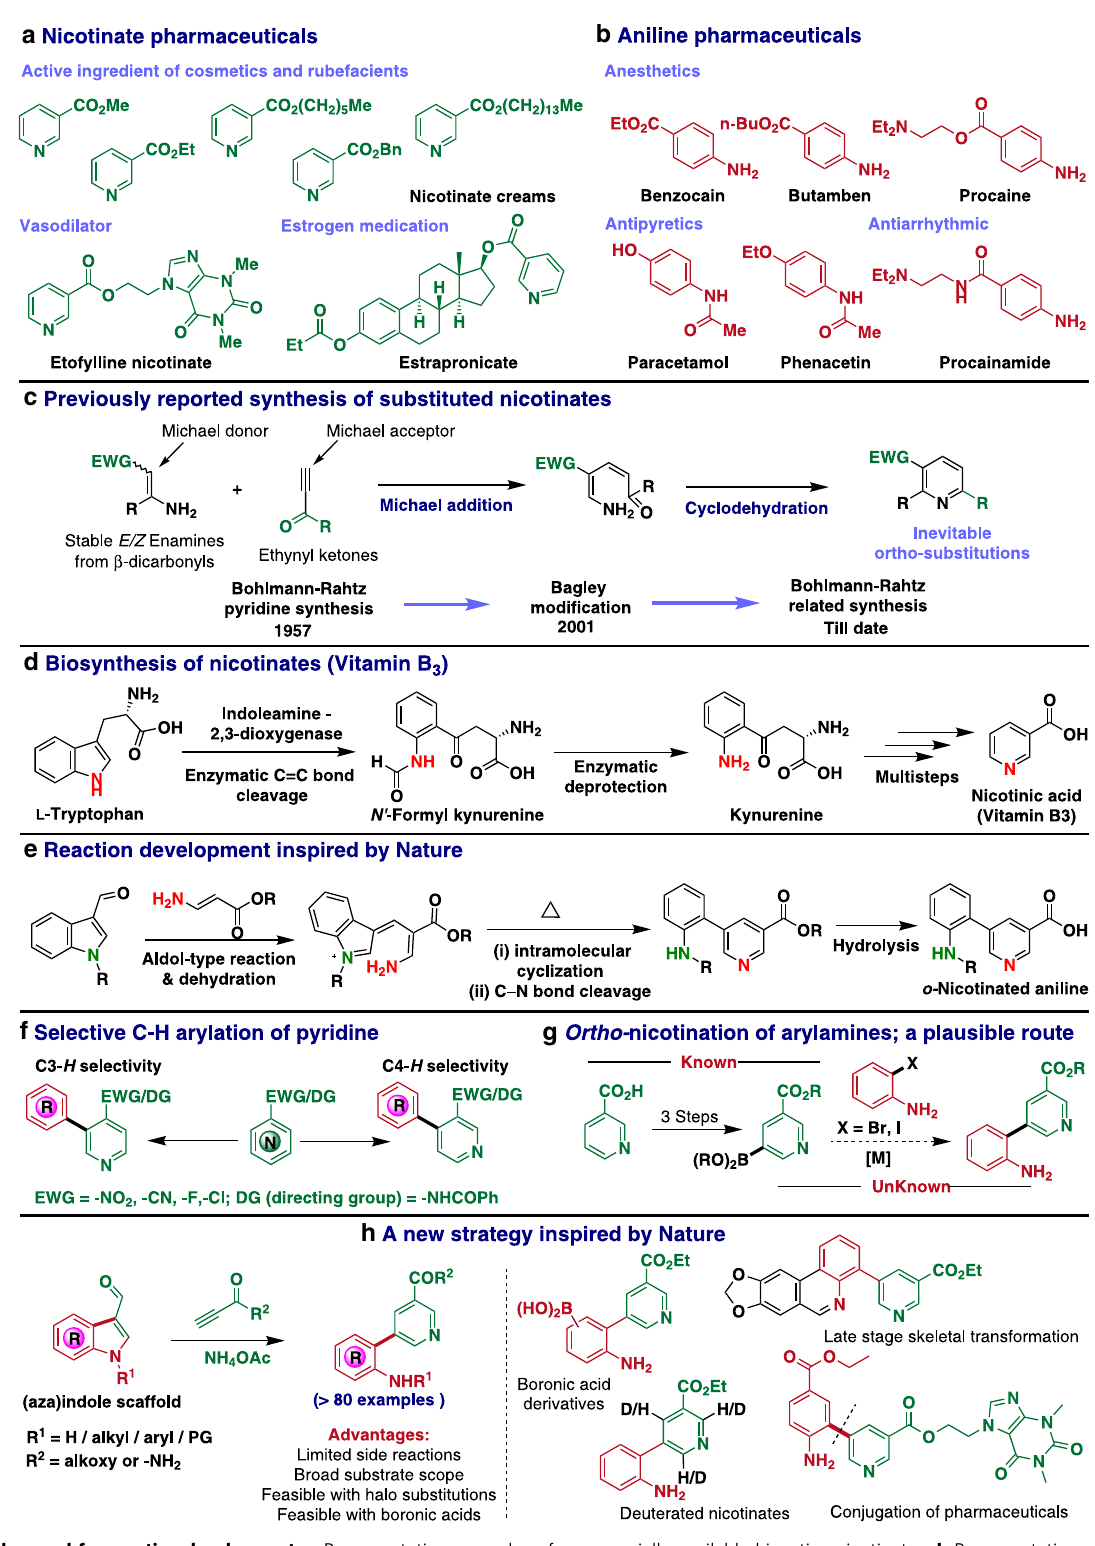
Fig. 1 Background for reaction development. a Representative examples of commercially available bioactive nicotinates. b Representative examples of aniline-based pharmaceuticals. c Previously reported synthetic routes for substituted nicotinates with inevitable C 2 and C 6 substitutions. d